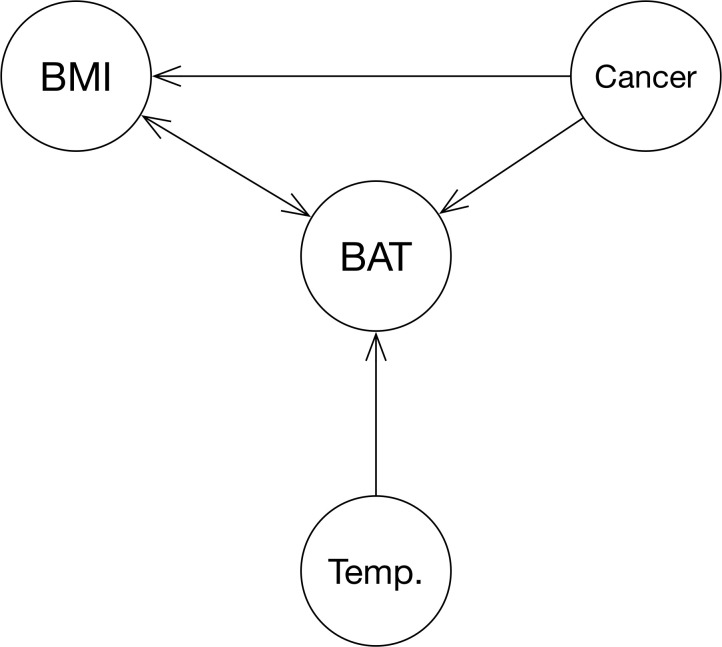
Directed acyclic graph (DAG) representation of the hypothesis that BAT is a mediator of cachexia in cancer patients, including ambient temperature (Temp.) as a potential known confounder.Age and sex have been omitted in this graph for simplicity since they are known and, more importantly, non-modifiable factors.